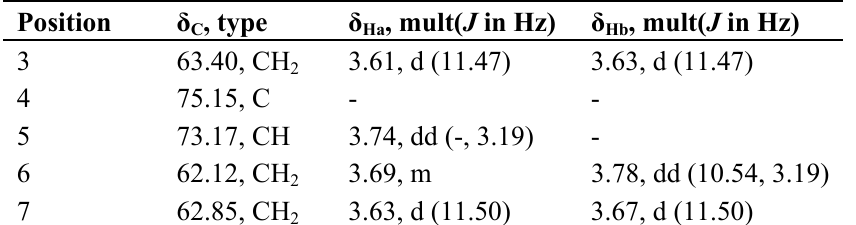
Table 1. NMR spectroscopy data for kramecyne (500 MHz, methanol-d